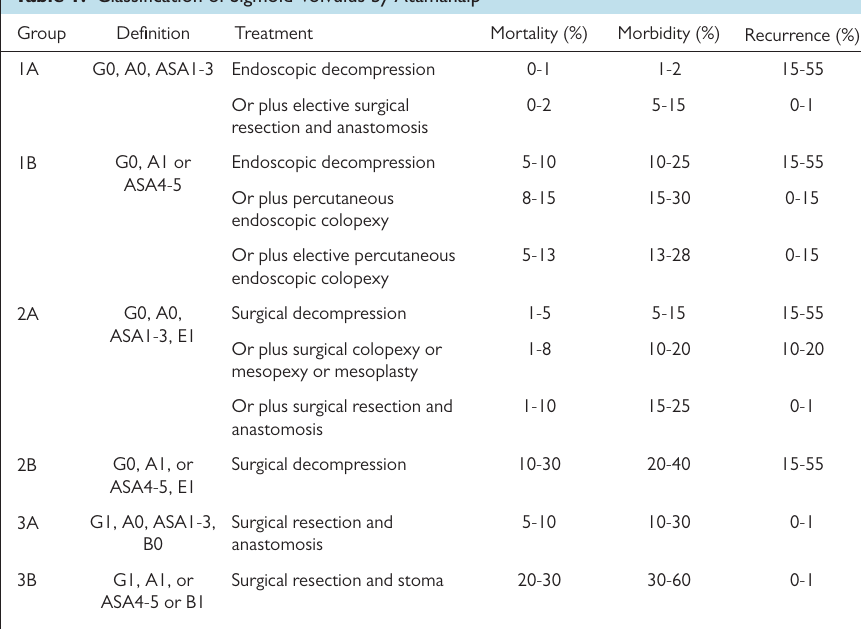
Table 1. Classification of Sigmoid Volvulus by Atamanalp 21